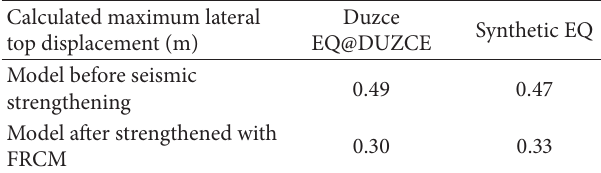
Table 4: Maximum lateral displacements of top of minaret accord- ing to time history analyses before and after seismic